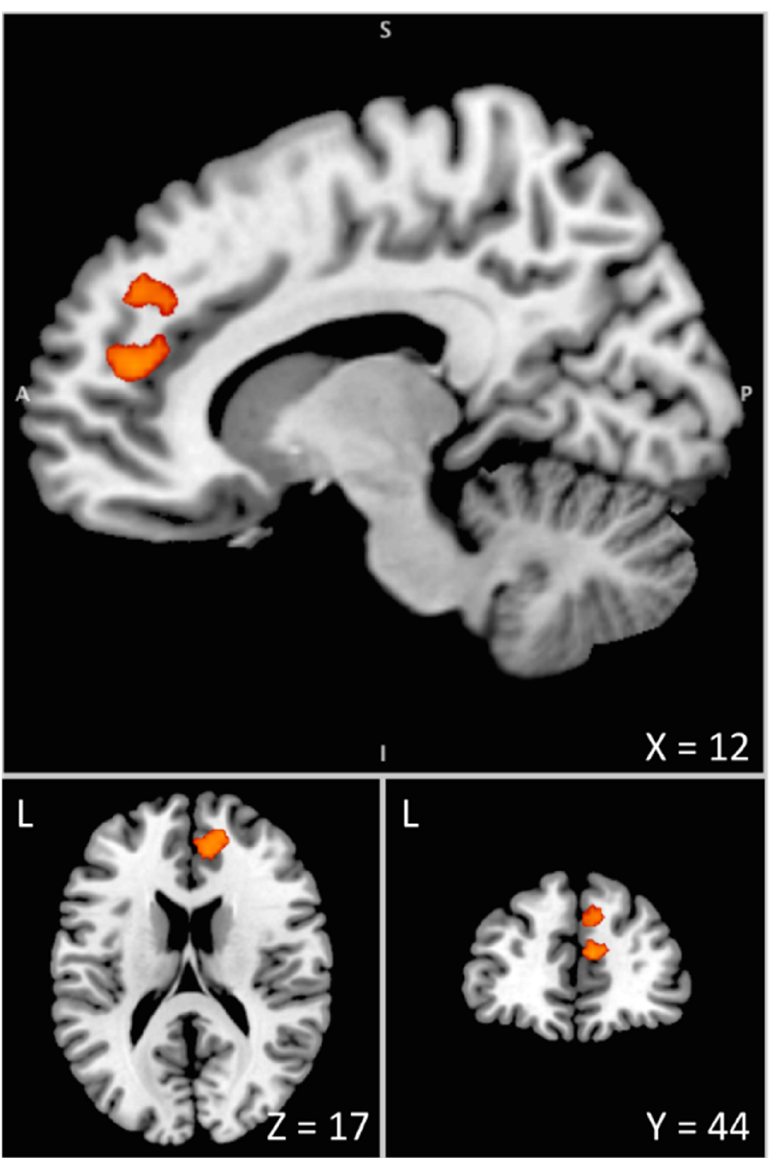
Figure 5. Interaction between drug and disease effects during the pre-stimulus period assessed by means of the [(green cue_(clonidine-placebo)_Patients)-(green cue_(clonidine-placebo)_Controls)] contrast. The differential increase in BOLD signal under clonidine between PD patients and healthy controls is overlaid on the Colin 27 brain template in the MNI space visualized with the Mango software [43]. This overactivation of the anterior node of the proactive inhibition network (mPFC/ACC) is associated with the enhanced difficulty of PD patients to initiate movements when action restraint is not required (control condition with no uncertainty) under the effect of clonidine. L = Left. A = Anterior. S = Superior. X,Y,Z are coordinates in mm in the MNI space.